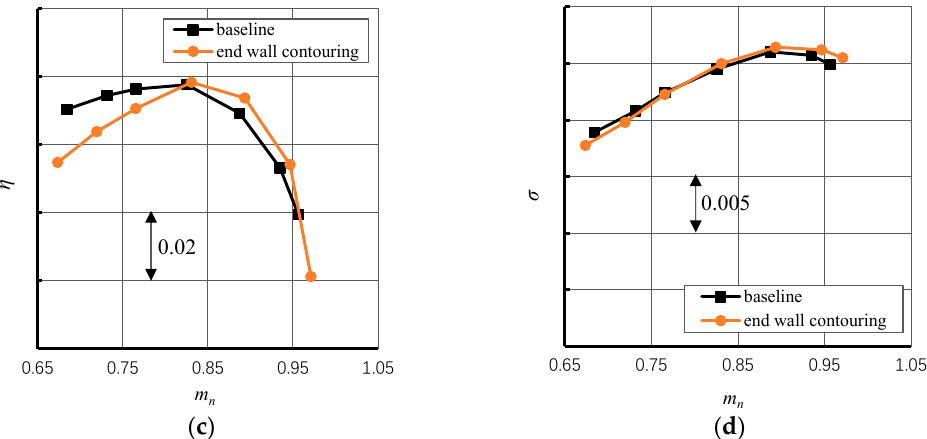
Figure 14. The overall performance of the compressor stage at 70% design speed. ( a ) Total pressure ratio of the stage; ( b ) Total temperature ratio; ( c ) Efficiency of the stage; ( d ) Total pressure recovery coefficient of the stator (the values of the overall performance are not shown here for confidential reasons. The figure shows only the normalized mass flow rate and the unit of the vertical axis).